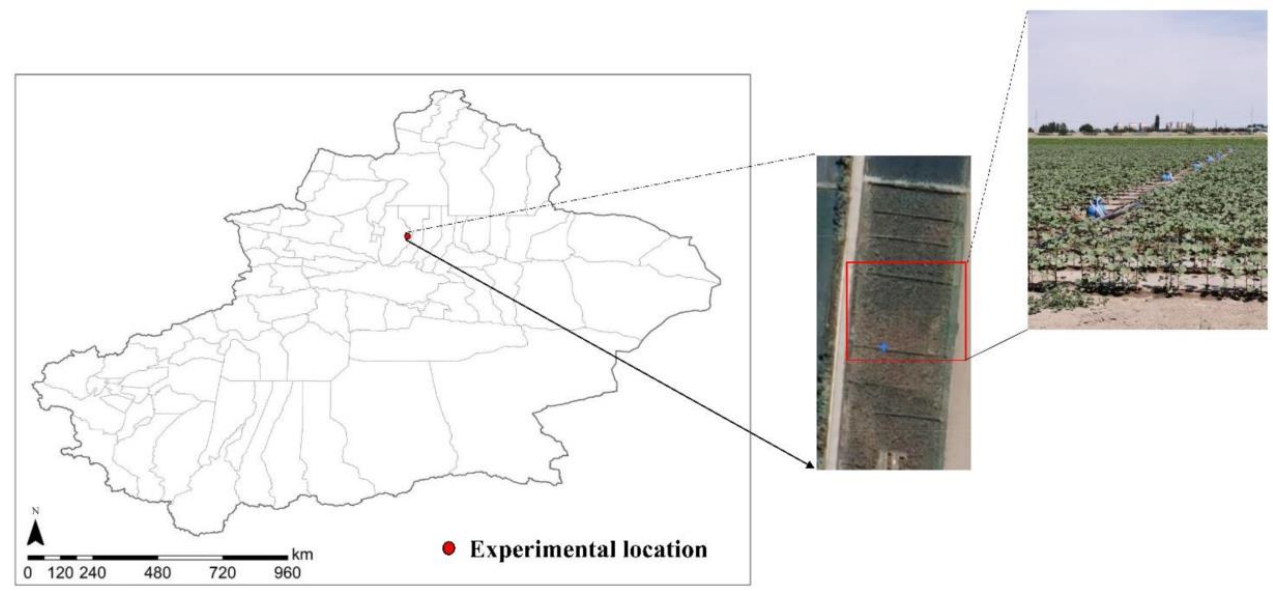
Figure 1. Location of the experimental area—Shihezi, Xinjiang, China.